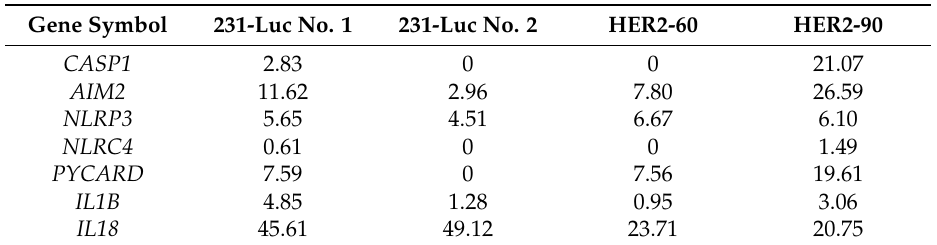
Figure 2. The expression levels of caspase-1 and its related genes were decreased in the metastatic brain with HER2-60 cells. ( a ) mRNA levels of caspase-1-related genes of cancer cells in the metastatic brains with 231-Luc, HER2-60, and HER2-90 cells. The values are shown in Table 1; ( b , c ) relative mRNA levels in the metastatic brains with HER2-60 cells compared with those with HER2-90 cells; ( b ) relative mRNA levels of cancer cells; ( c ) relative mRNA levels of mouse stromal cells. The values are shown in Table S6. Table 1. Expressions levels of mRNA.